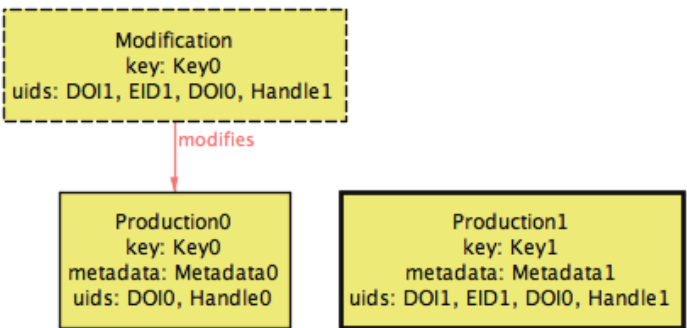
Figure 8. PTCRIS profile after IMPORT